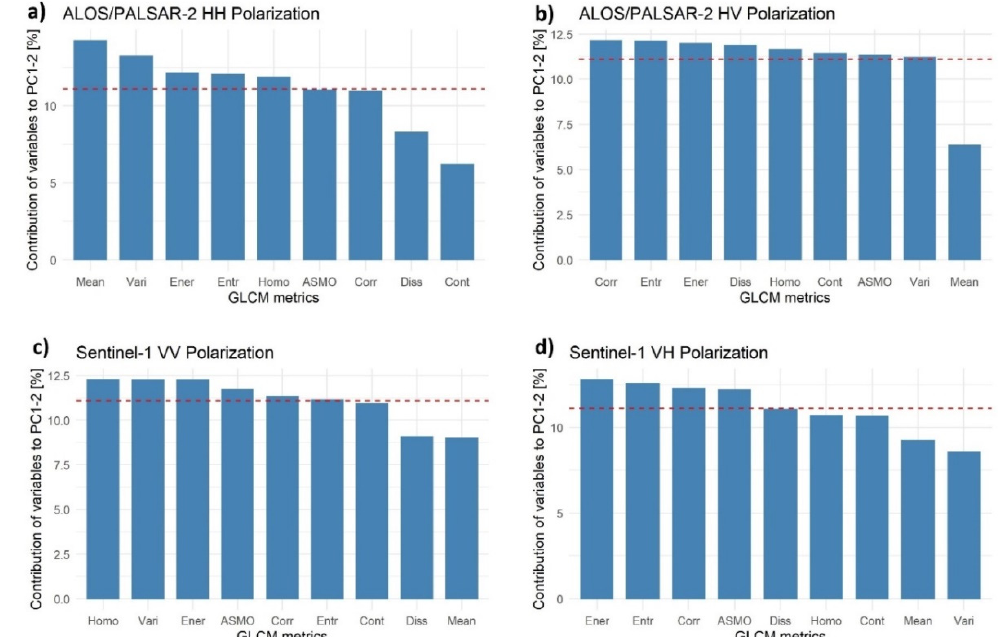
Figure 5. Contributions of the texture variables to the PC1 and PC2 components for ALOS/PALSAR-2 HH polarization ( a ), ALOS/PALSAR-2 HV polarization ( b ), Sentinel-1 VV polarization ( c ), and Sentinel-1 VH polarization ( d ). The red dashed line indicates the mean value at which the contributions were uniform. Table 2. Organization of texture features used in each experiment, after PCA analysis.